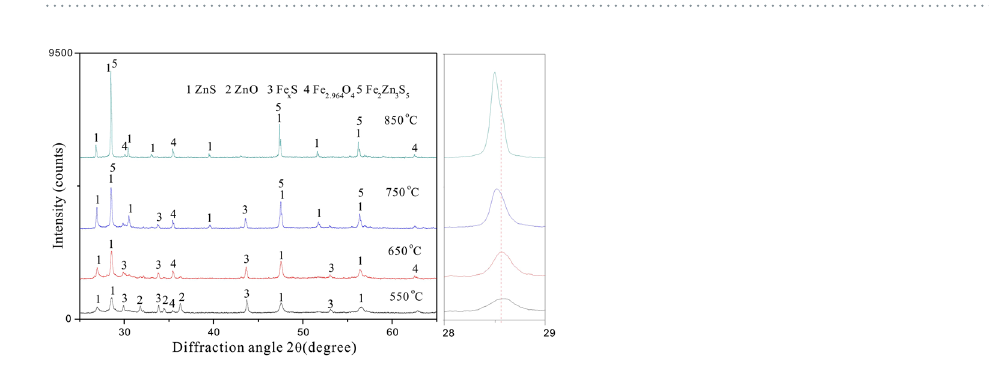
Figure 5. XRD patterns of the roasted products at different temperatures (n FeS2 :n ZnO =